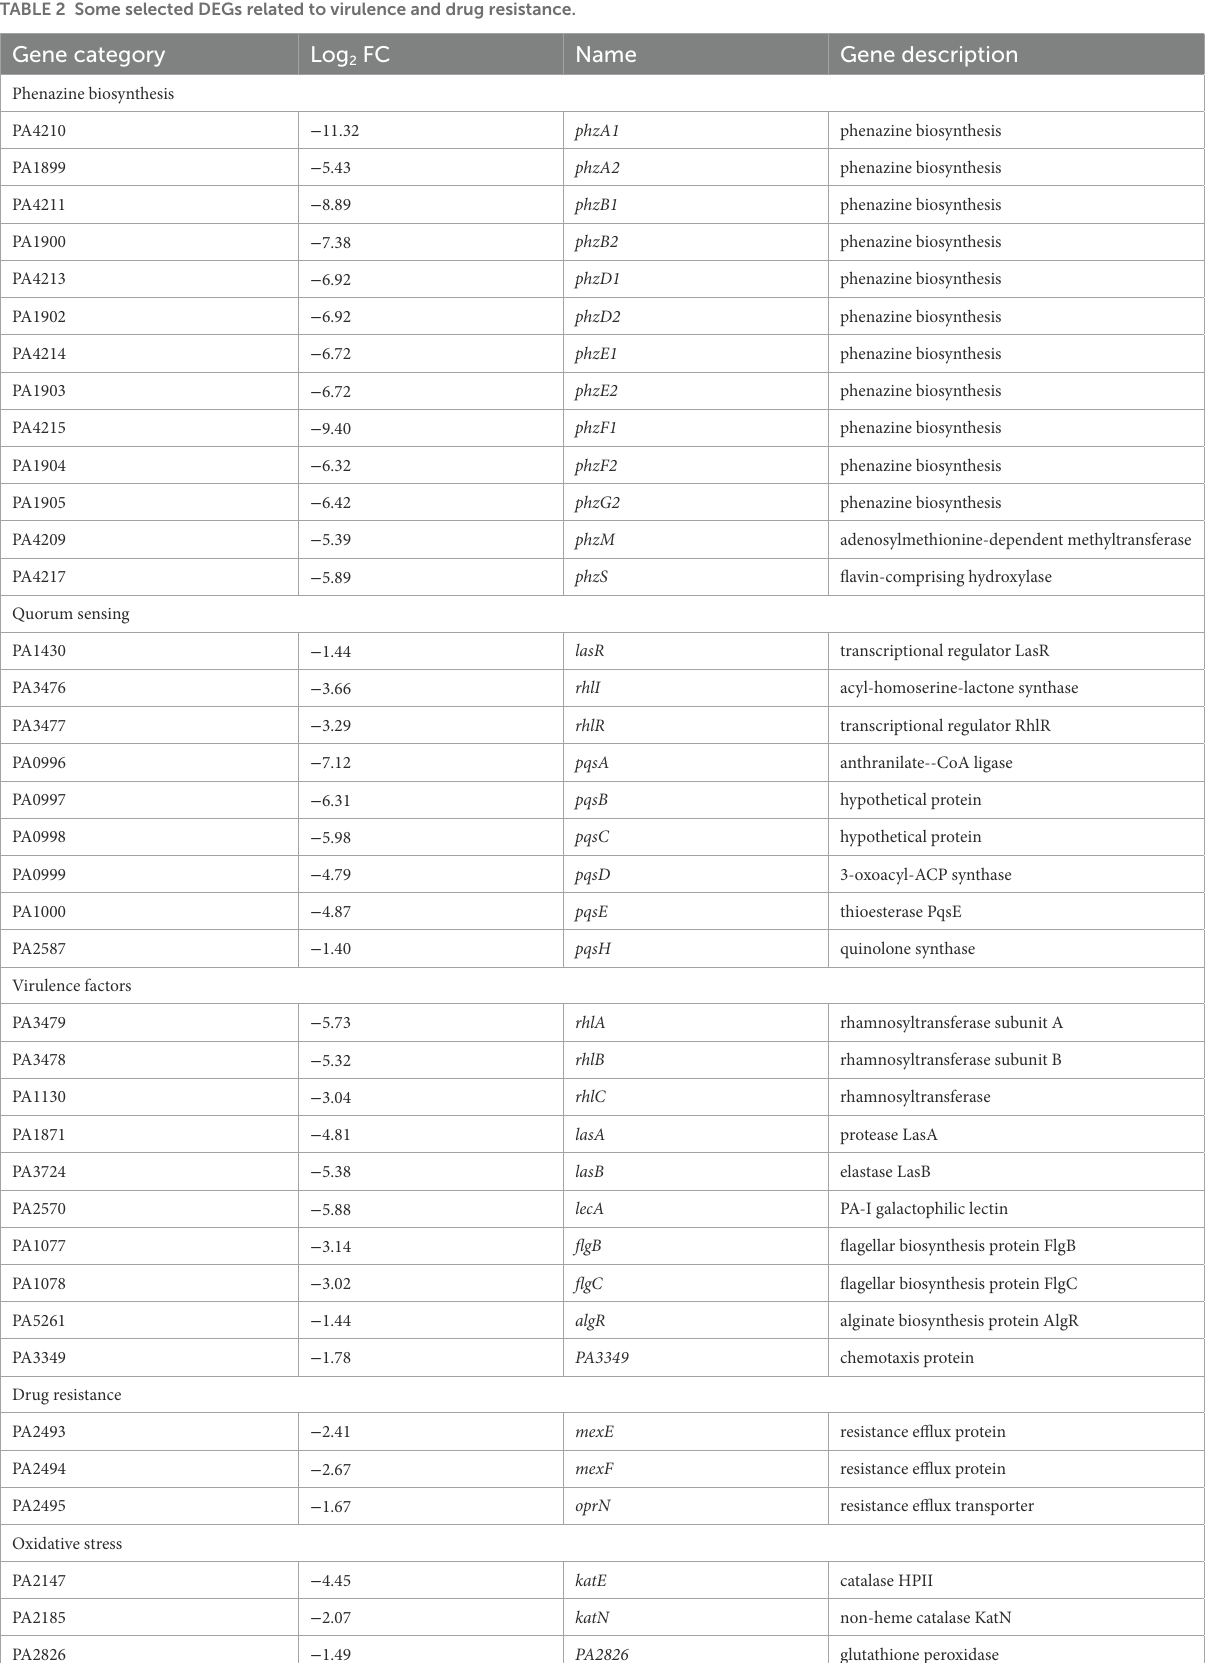
TABLE 2 Some selected DEGs related to virulence and drug